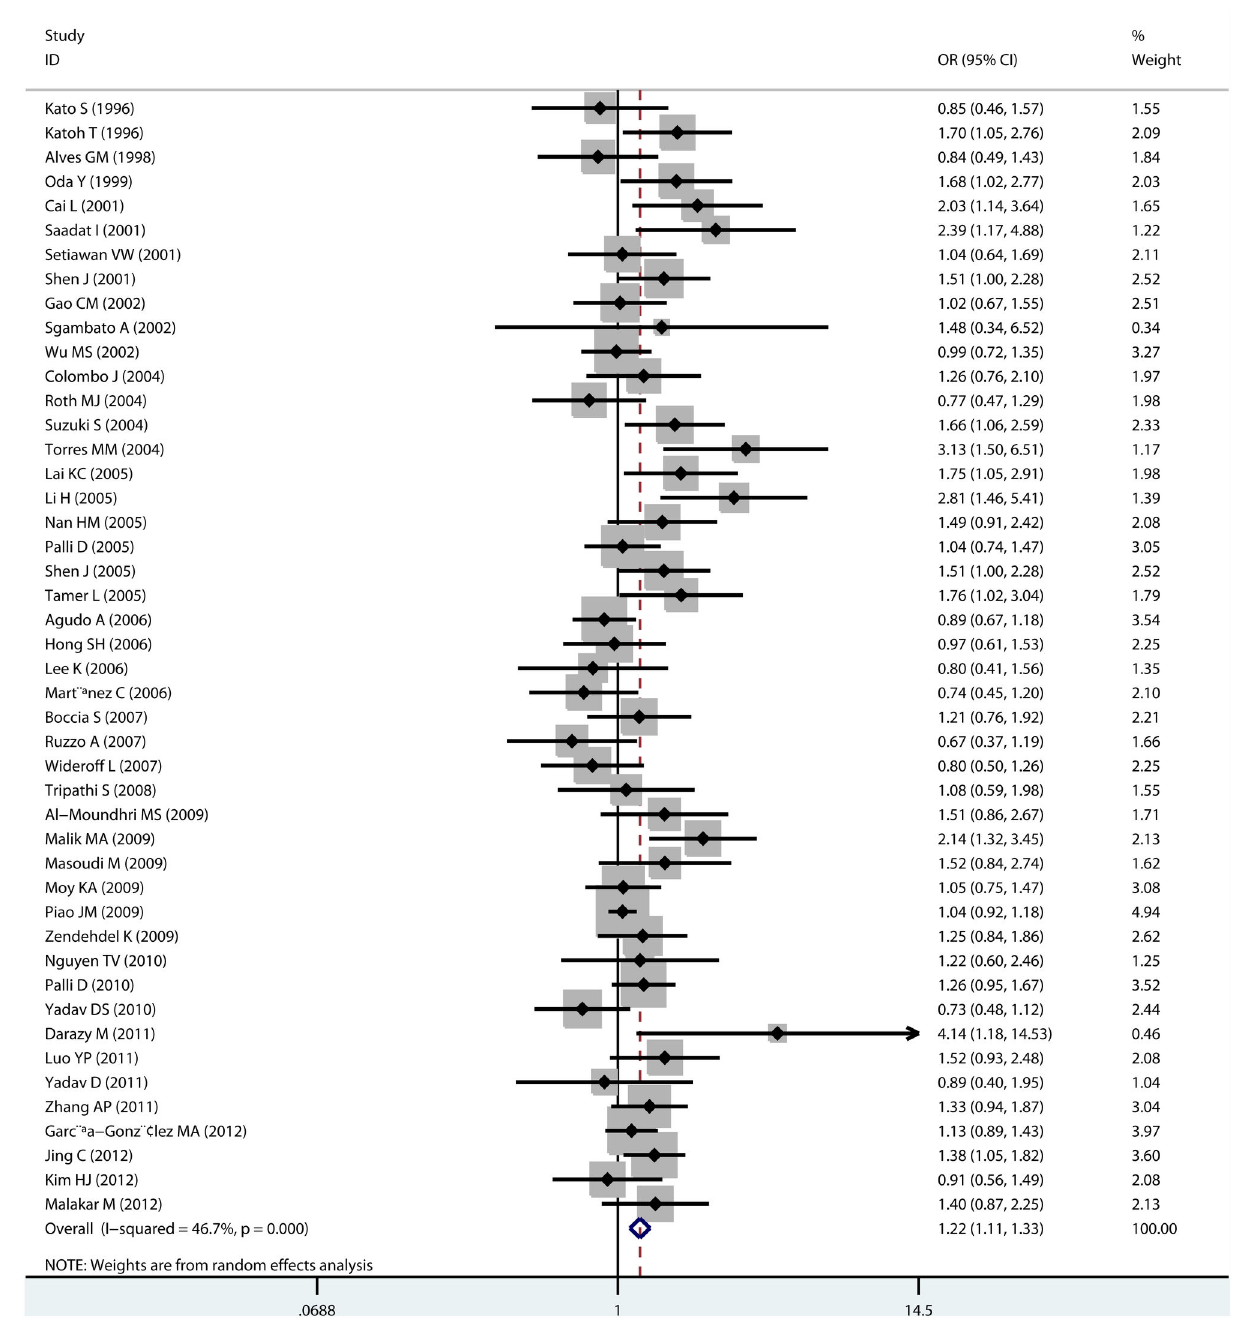
Figure 2. Overall analysis of GSTM1 null genotype and gastric cancer risk. A number of 46 studies were included.